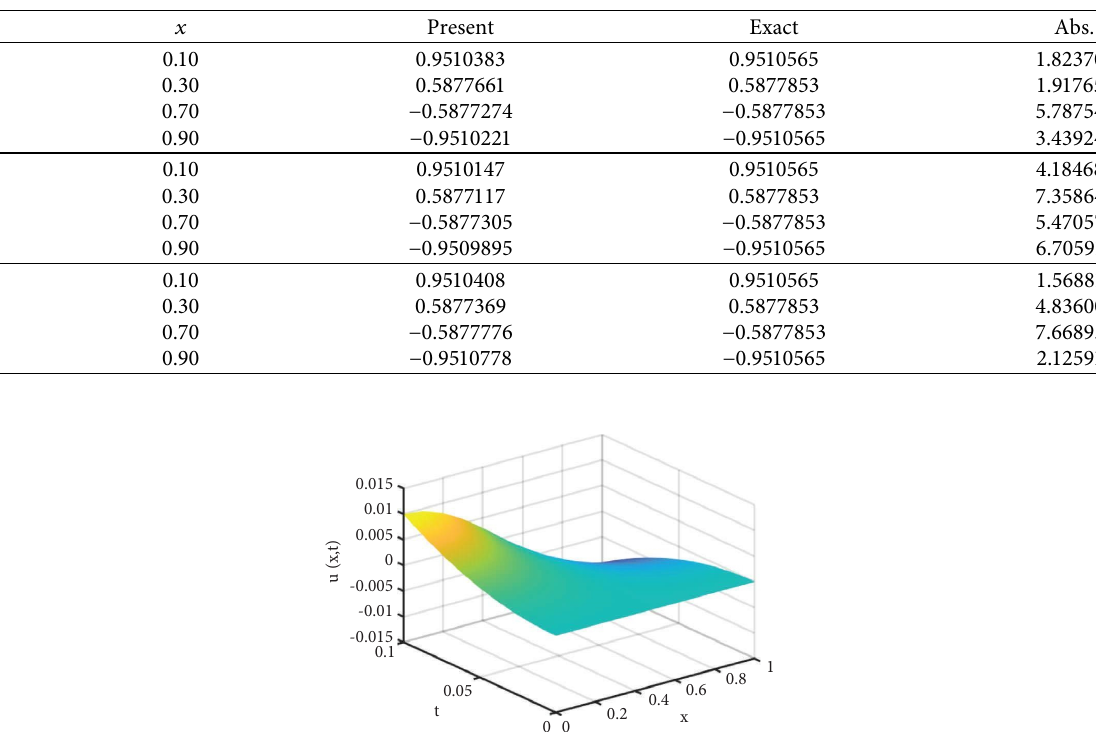
Table 3: Results of Example 1 at T � 1, h � 0 . 01, ] � 0 . 1, and α � 0 . 9.